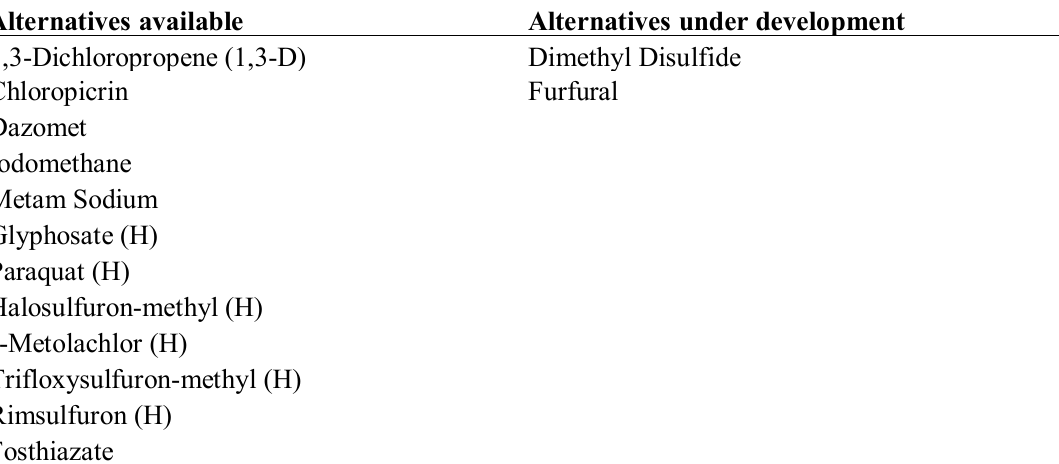
Table 1. Primary methyl bromide alternatives for the Florida Tomato